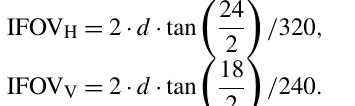
significantly affect size estimates. The Otsu method (Otsu, 1979) was applied to evaluate the optimal threshold